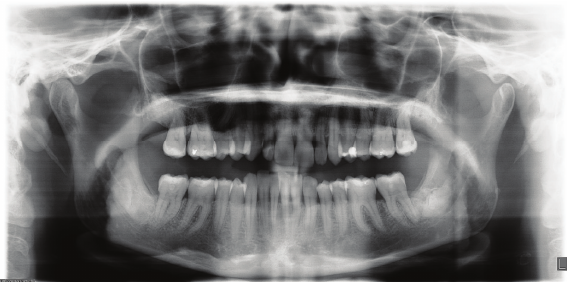
Figure 5: A 23-month follow-up with excellent